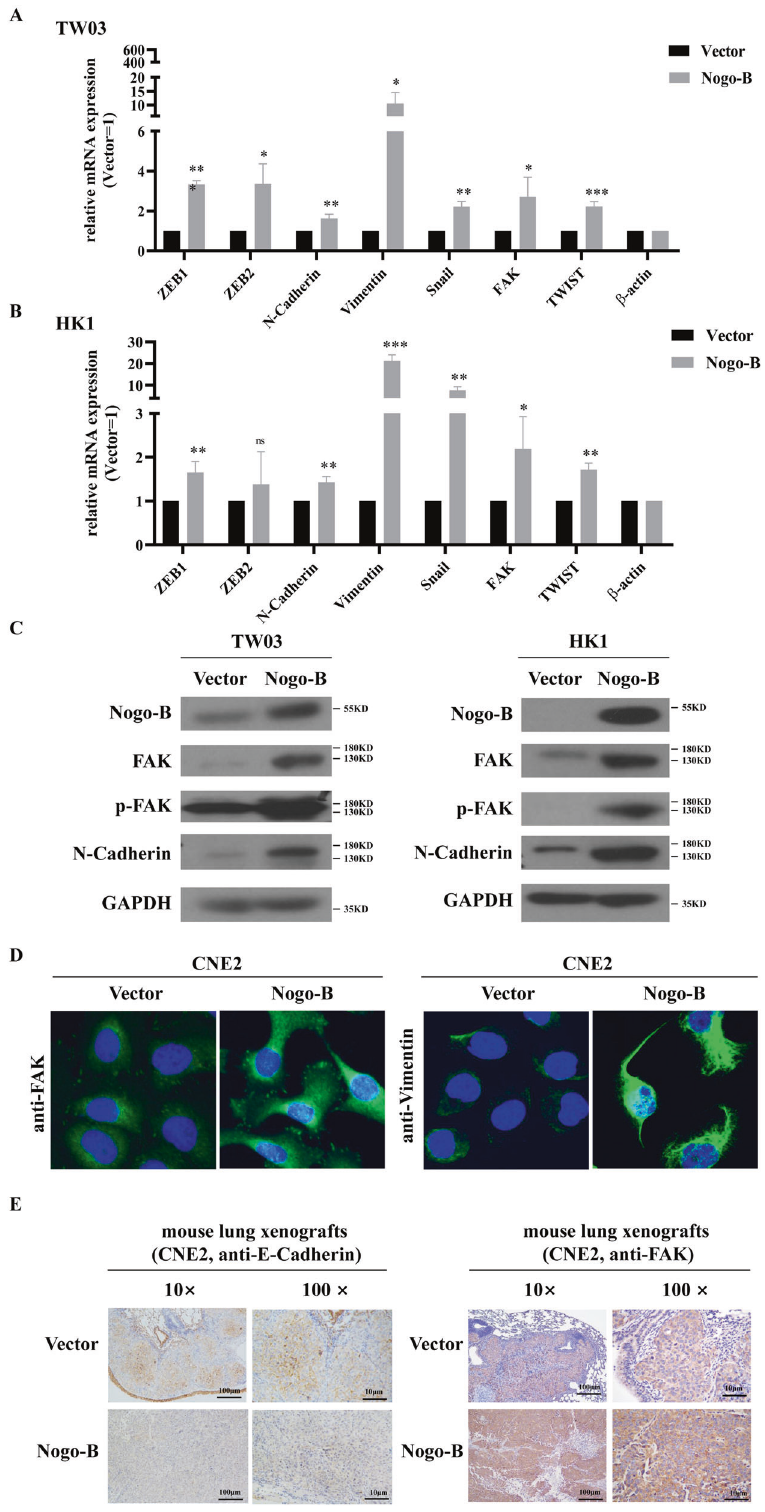
Fig. 5 Nogo-B promotes NPC cell migration by regulating EMT. A Real-time PCR showed overexpressing Nogo-B increased the expression of EMT markers, such as ZEB1, ZEB2, N-Cadherin, Vimentin, Snail, FAK, TWIST, etc. in TW03 cell lines. B Real-time PCR showed overexpressing Nogo-B increased the expression of EMT markers, such as ZEB1, ZEB2, N-Cadherin, Vimentin, Snail, FAK, TWIST, etc. in HK1 cell lines. C Western blotting showed FAK, p-FAK and N-Cadherin expression increased in Nogo-B overexpressing TW03 (left) and HK1 (right) cells. D Immuno fl uorescence showed that Nogo-B upregulated the expression of FAK and Vimentin. E Immunohistochemistry showed that overexpressing Nogo-B downregulated E-Cadherin expression and upregulated FAK expression.